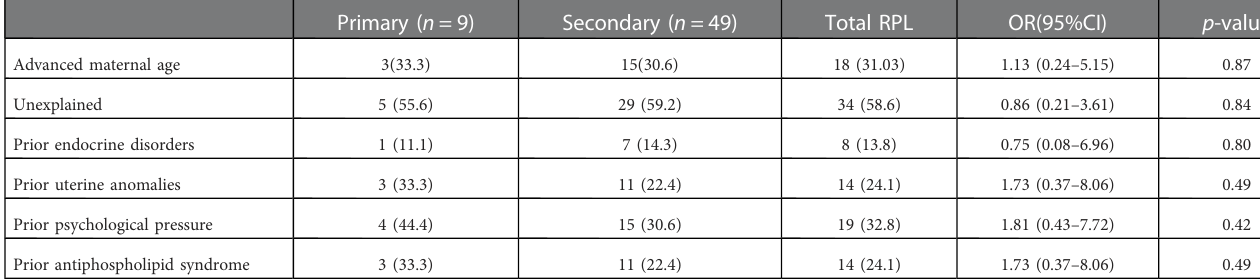
TABLE 7 Risk factors for RPL among participants with prior RPL according to type of miscarriage (primary vs